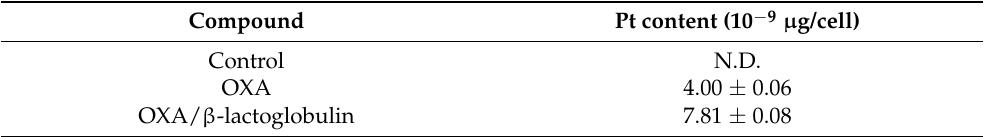
Table 2. Platinum content in A431 cancer cells measured with ICP-AES. Values are given as means ± SD ( n = 2). Control cells are untreated cells. N.D., not detected.